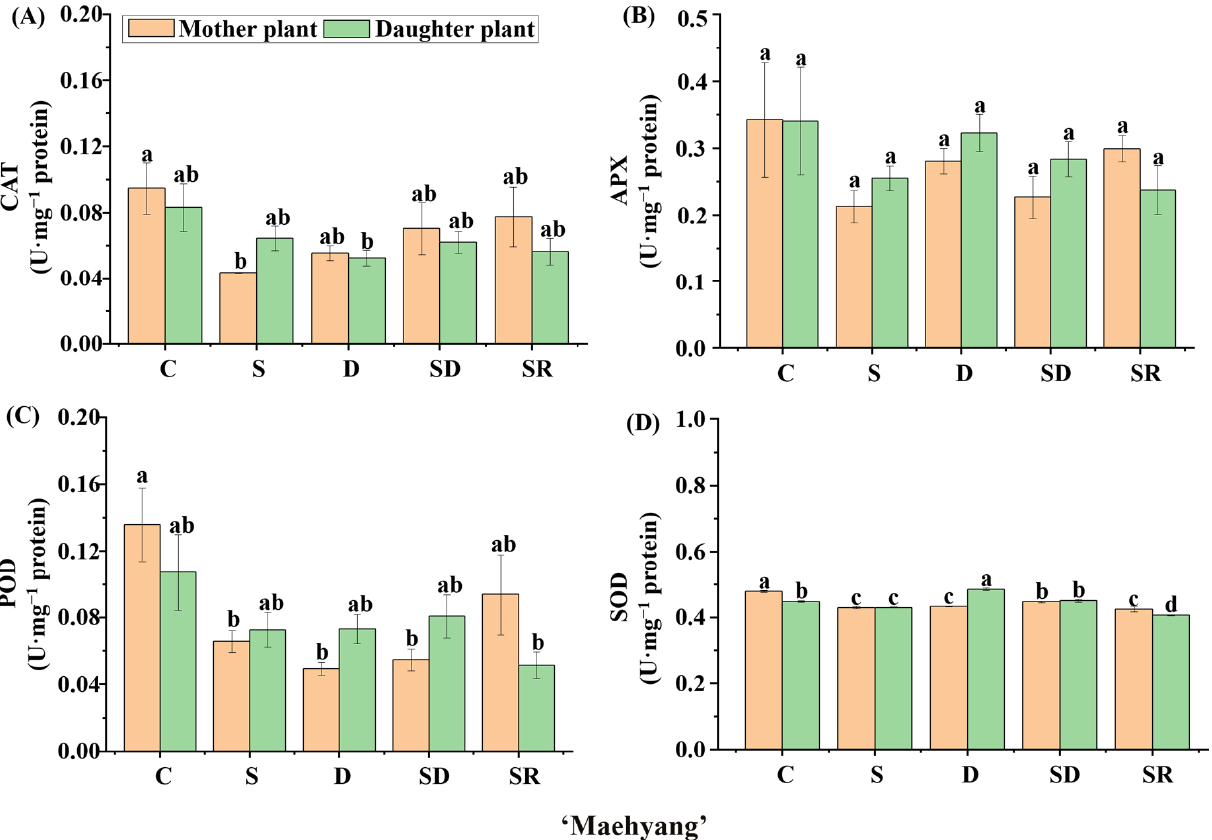
Figure 9. The activities of catalase (CAT) ( A ), ascorbate peroxidase (APX) ( B ), guaiacol peroxidase (POD) ( C ), and superoxide dismutase (SOD) ( D ) in ‘Maehyang’ as affected by the Si treatments. Lowercase letters indicate significant differences calculated by the Duncan’s multiple range test at p ≤ 0.05: C, control; S, sprayed “mother” plant; D, drenched “mother” plant; SD, dressed “mother” plant; and SR, sprayed “daughter” plant.